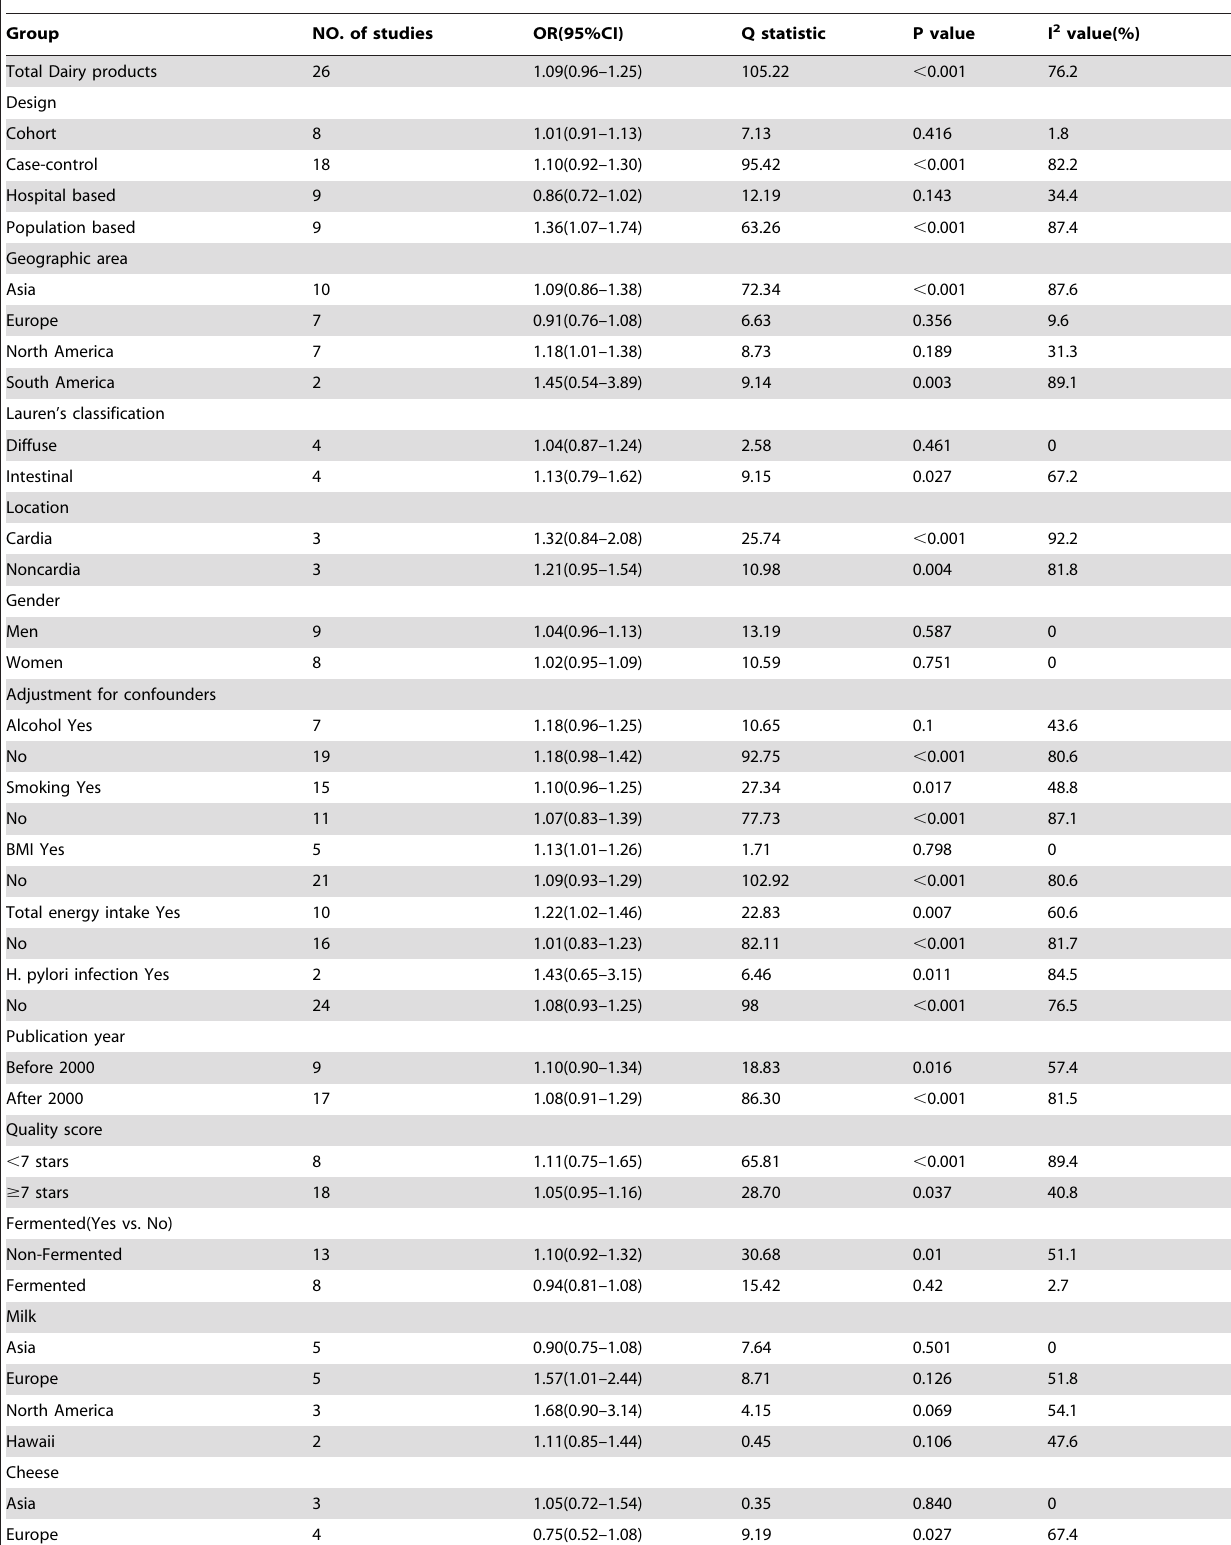
Table 3. Stratified Analysis of dairy products or milk Intake and gastric cancer Risk.